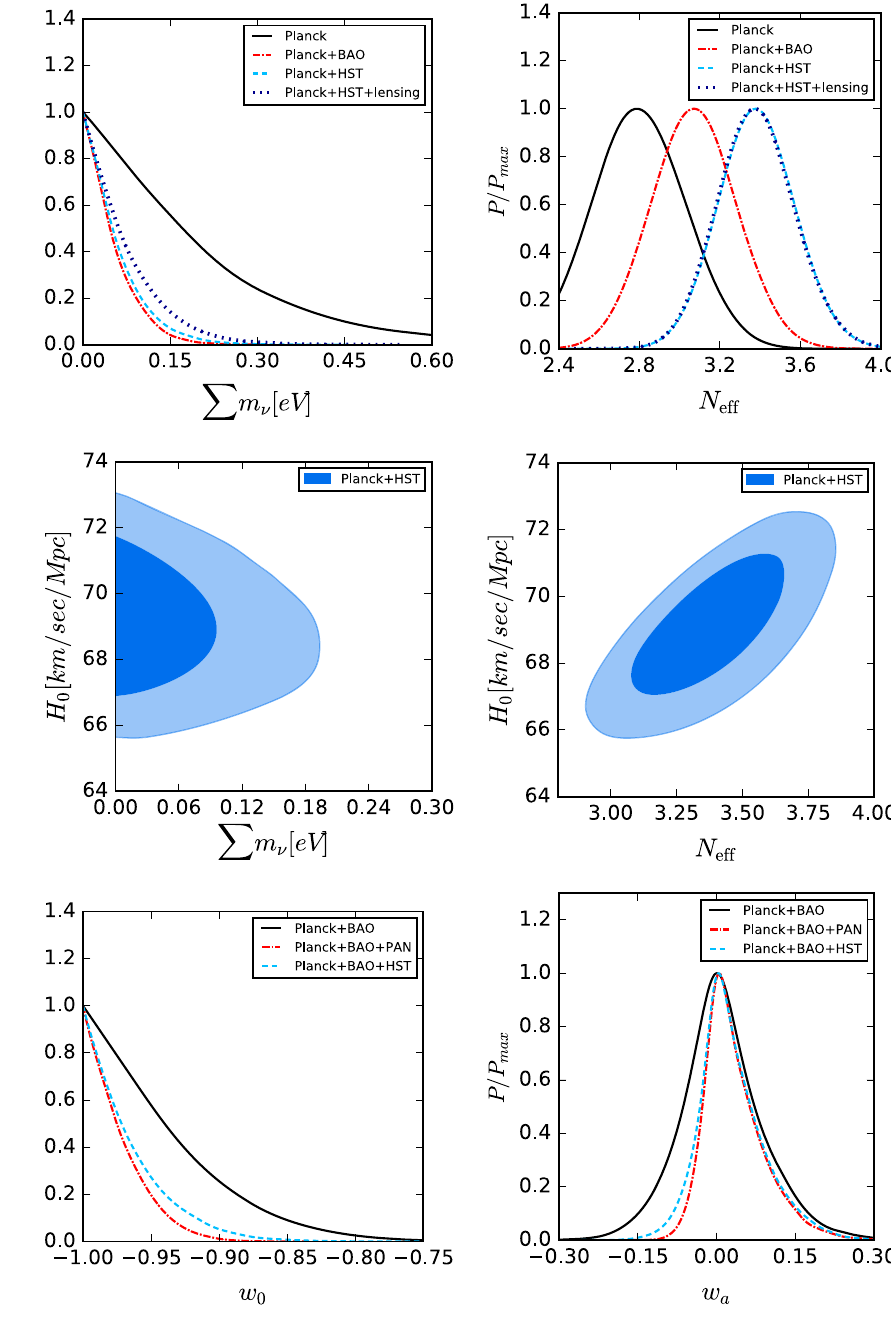
Fig. 5 Comparison of 1-D marginalized posterior (cid:2) m ν (eV) and distributions for N eff for various data combinations in NPDDE11